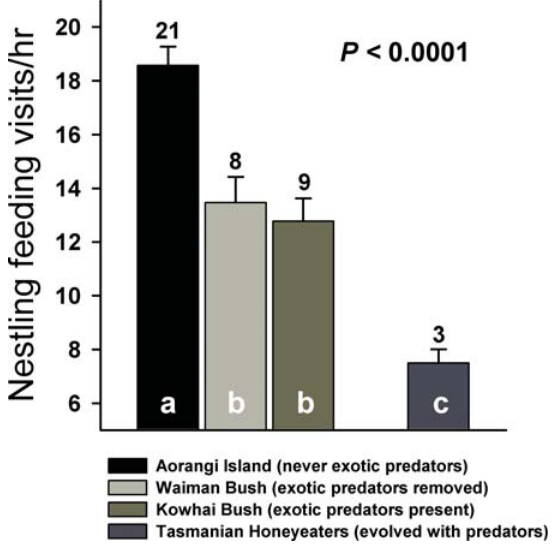
Figure 4. The number of parental visits to the nest per hour to feed nestlings for bellbirds on Aorangi Island, where exotic predators were never introduced, for bellbirds in Waiman Bush, where exotic predators were removed, for bellbirds in Kowhai Bush, where all exotic predators are present, and for honeyeaters in Tasmania, which evolved with a range of native mammalian predators. Shared letters within bars denote non- significant (i.e., p . 0.05) statistical differences based on LSD tests. Figures above bars are the number of nests filmed in each study site.